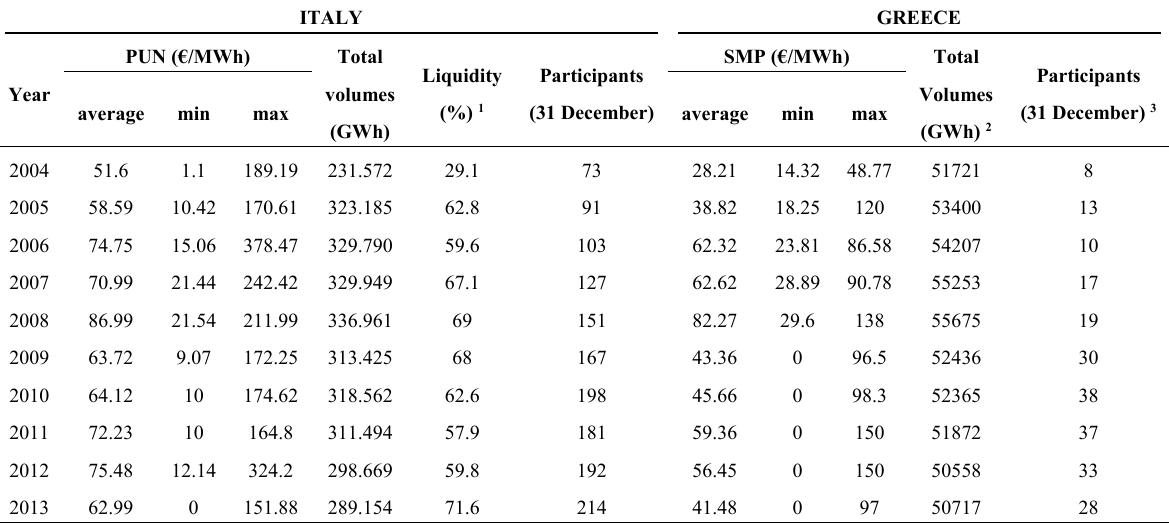
Table 2. Italian and Greek electricity markets main indicators (2004–2013). ITALY GREECE